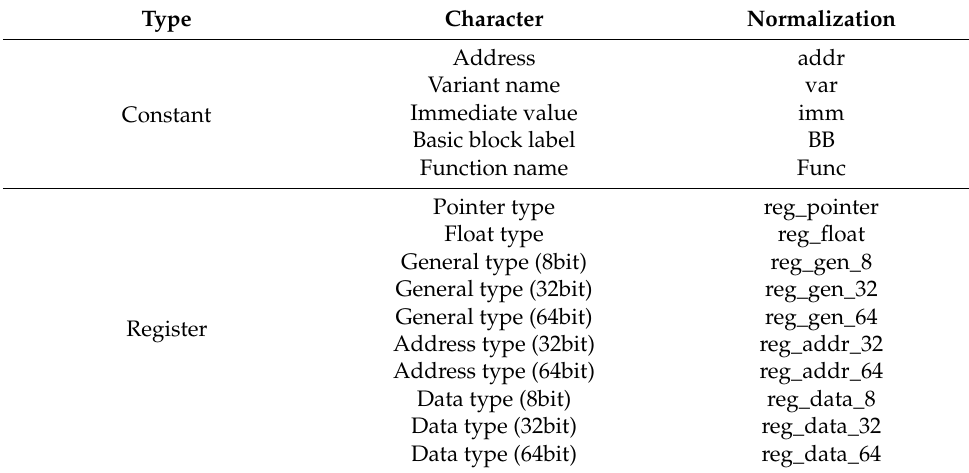
Table 2. Instruction normalization rule